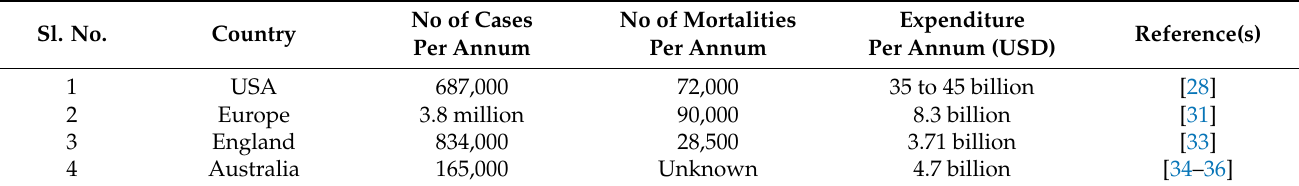
Table 1. Showing the implications of healthcare-associated or hospital-acquired infections (HAIs) in the USA, the UK, Europe, and Australia, including the annual number of registered infections, the number of mortalities per annum, and the annual expenditure calculated. Sl.